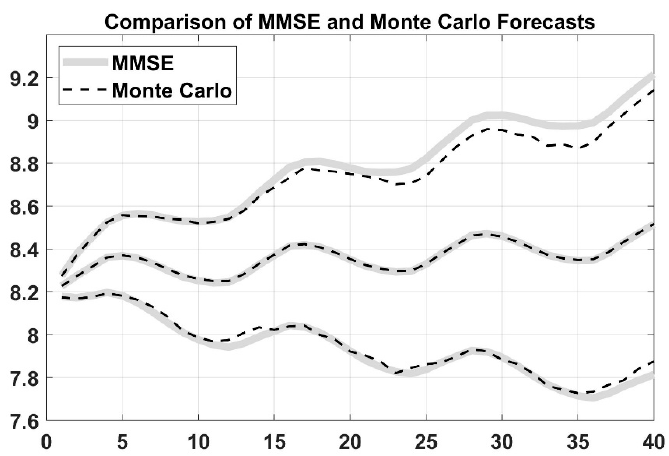
Figure 24. Per hour forecasting validation using MC.